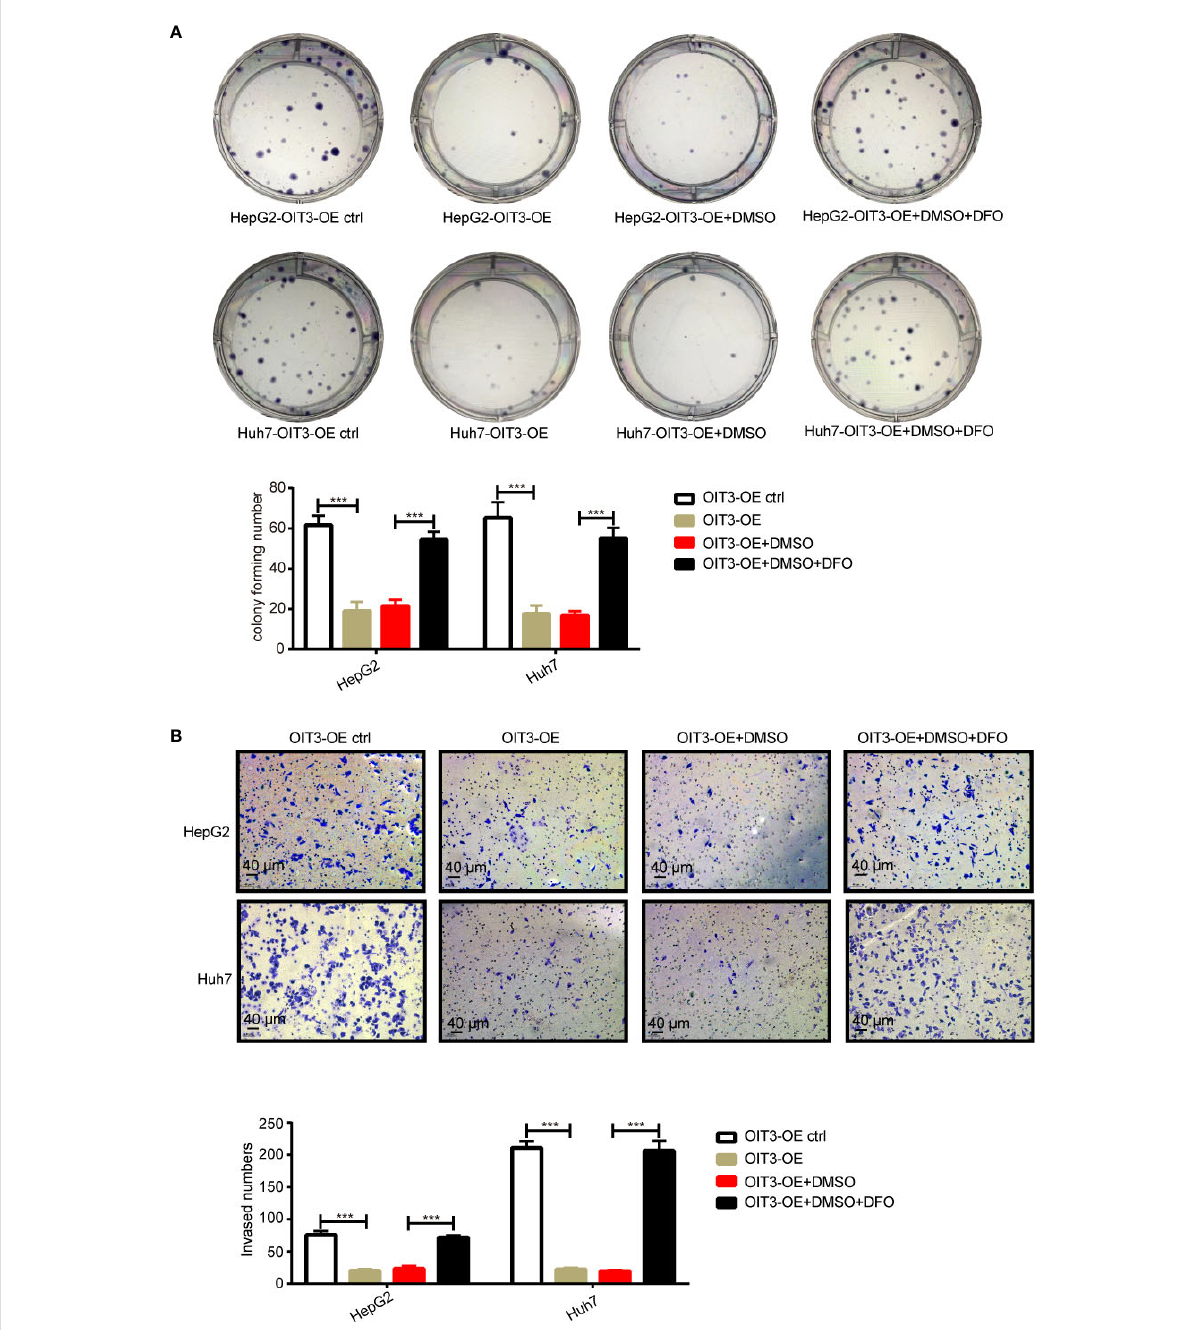
FIGURE 8 The OIT3 mediated-inhibition of clone formation and invasion abilities could be reversed by DFO. (A) The effect of DFO (100 m mol/L) on the clone formation ability of HepG2 and Huh7 cells. ( ***P < 0.001 ). (B) The effect of DFO (100 m mol/L) on the clone invasion ability of HepG2 and Huh7 cells. ( ***P < 0.001 ). Experiments were repeated three times, and the data are expressed as the mean ± SEM. OIT3-OE, OIT3-overexpressed lentivirus vector; OIT3-OE ctrl, OIT3-overexpressed lentivirus vector control; DFO, desferrioxamine; DMSO, dimethyl